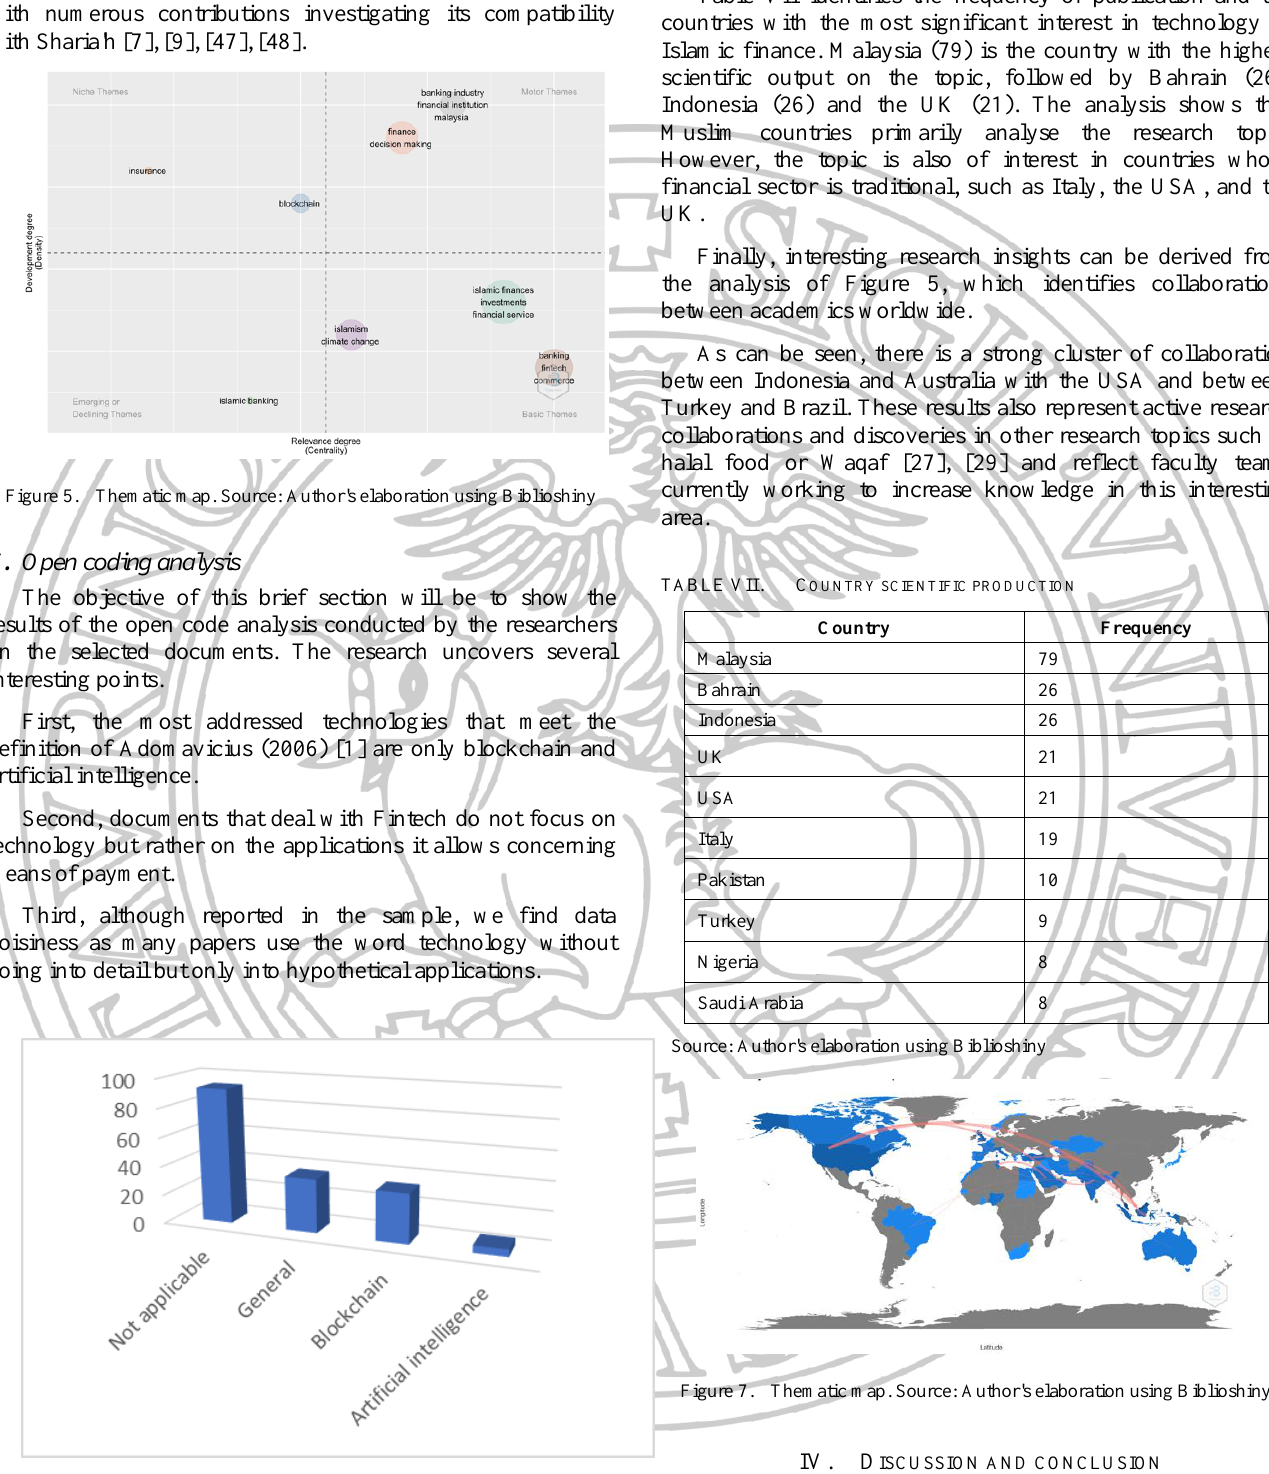
Figure 6. Coded technologies. Source: Author's elaboration using ATLAS.Ti Cloud